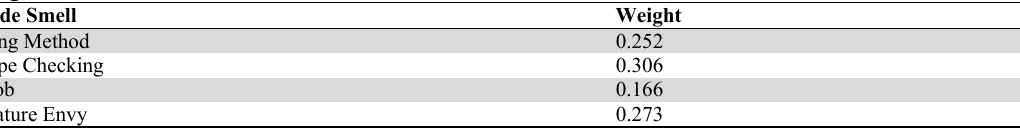
Weights of the code smell